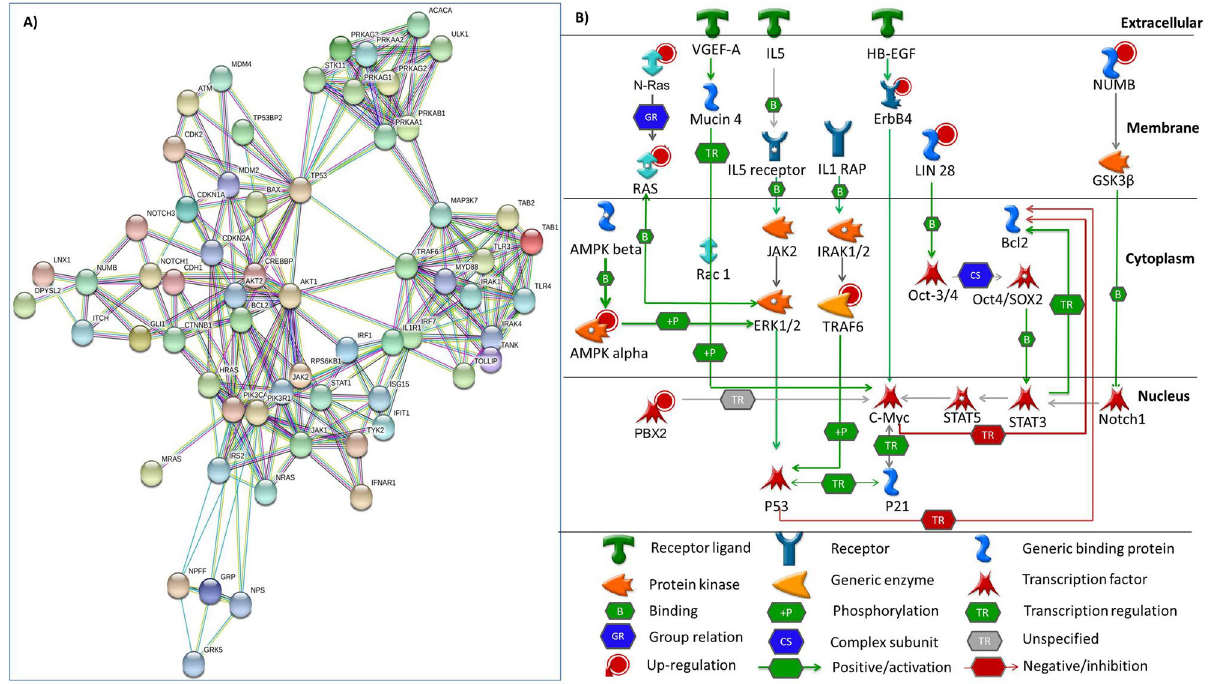
Figure 5. Target prediction analysis of mir-146a. ( A ) Network analysis of mir-146a predicted targets by STRING. The targets with score > 0.9 and P < 1.0e−16 were selected to achieve highest confidence ( B ) Pathway analysis performed using MetaCore showed up-regulated targets genes of mir-146a highlighted with round shape (red). The thickness of lines showed the extent of interaction with the target